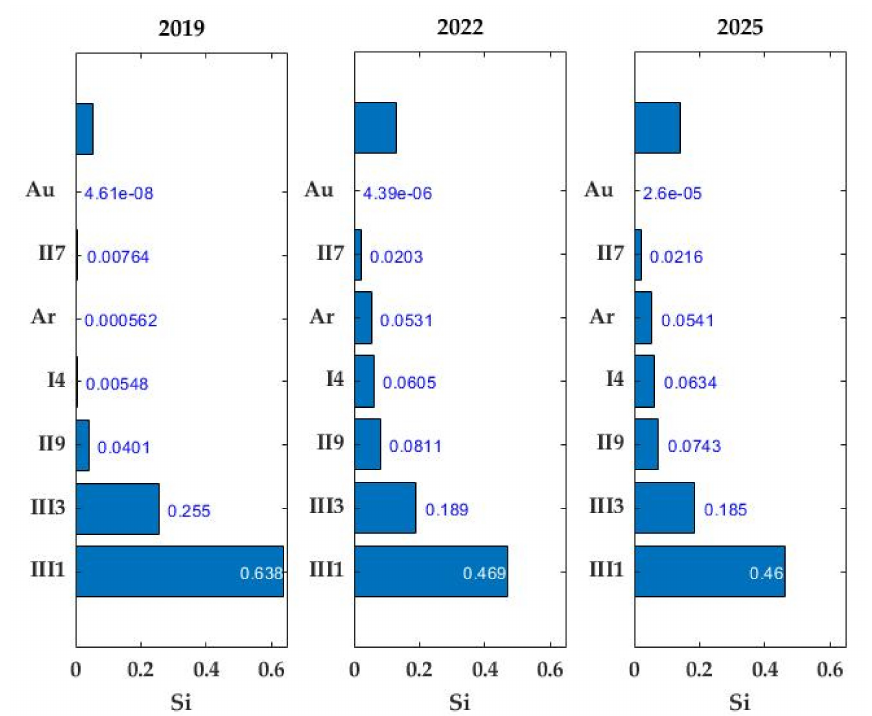
Figure 8. Sensitivity indices change over time in 2019, 2022, and 2025.